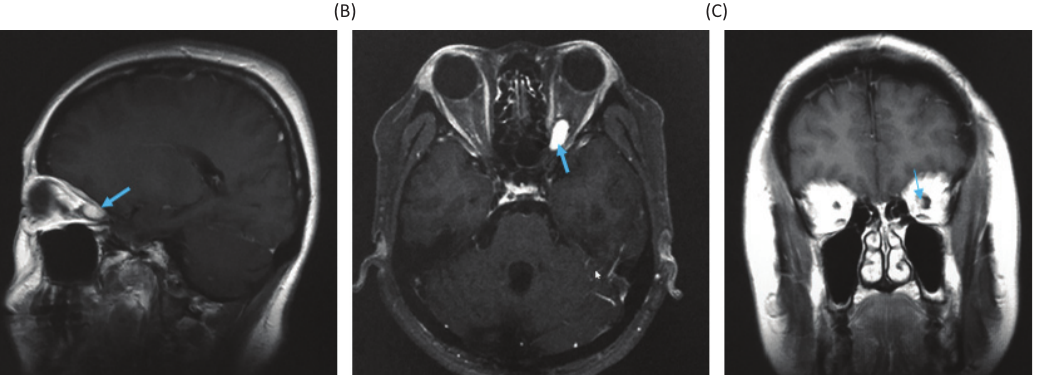
Figure 5. Gadolinium-enhanced magnetic resonance images at 18 months after the stereotactic radiosurgery. (A) Sagittal image. (B) Axial image. (C) Coronal